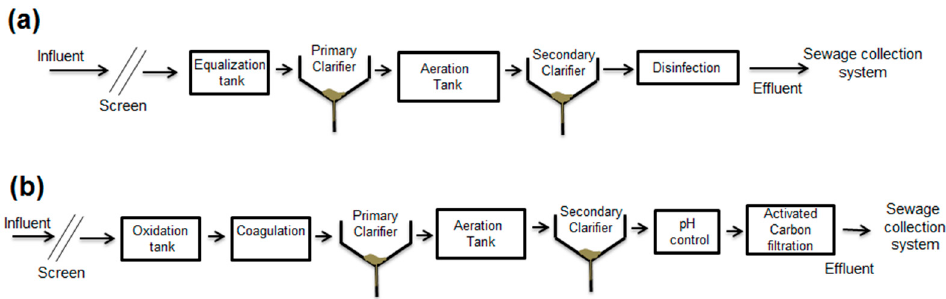
Figure 1. Schematics of the full-scale hospital wastewater treatment plant. ( a ) Represents the domestic wastewater (DWW) treatment train; and ( b ) for the hospital wastewater (HWW) treatment train. The hospital wastewater includes clinics and chemicals.